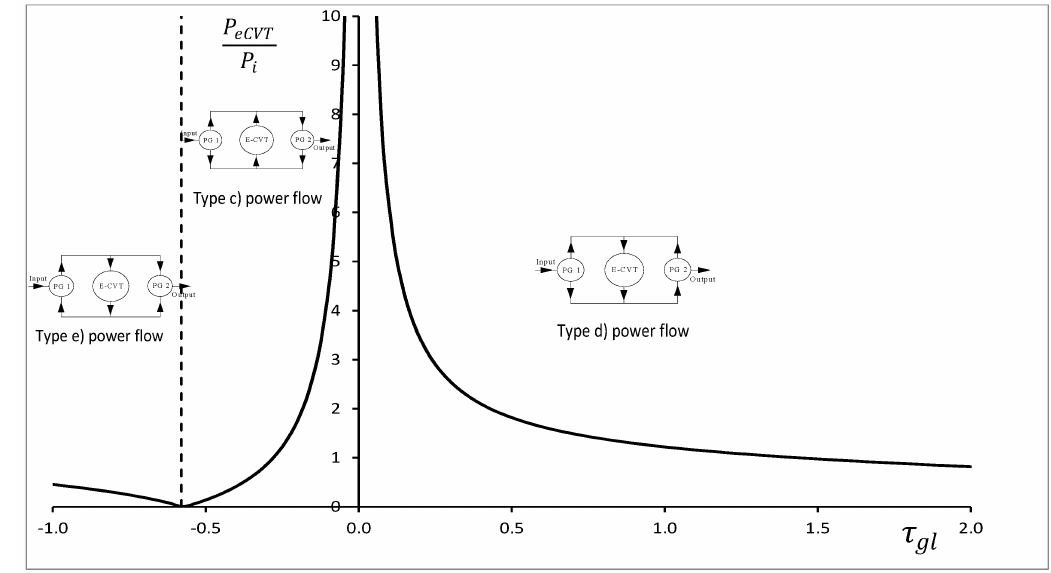
Figure 5. eCVT power fraction vs. global transmission